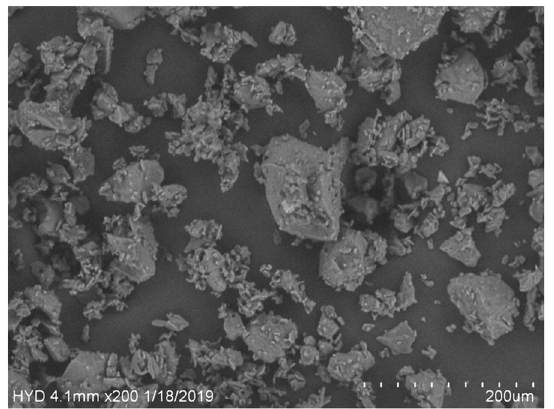
Fig. 10 SEM image of pure sulphanilamide (× 200)